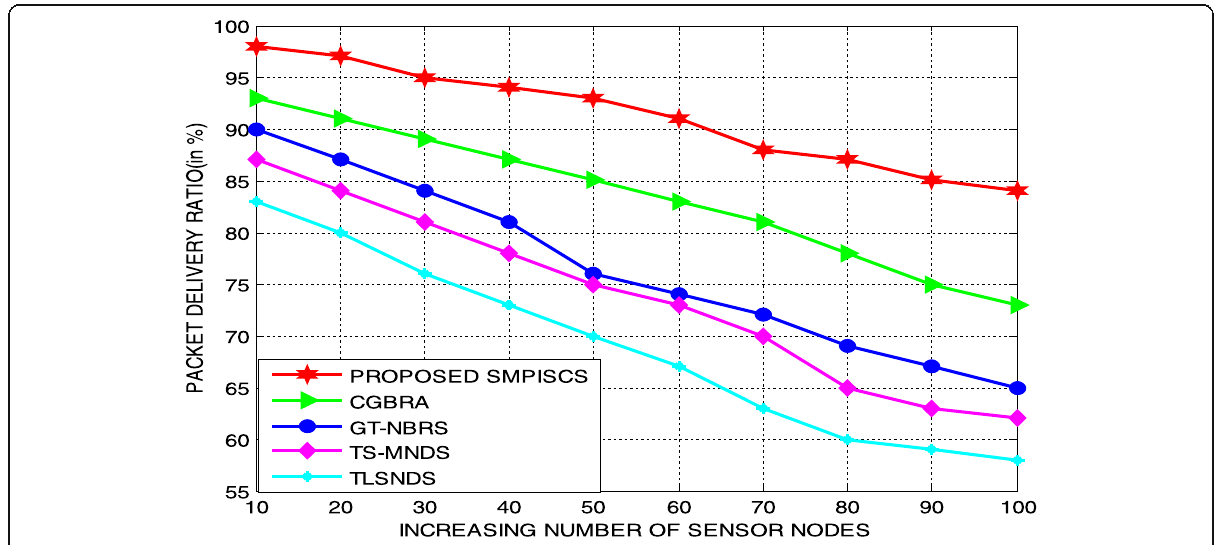
Fig. 3 SMPISCS-Packet delivery ratio (number of sensor